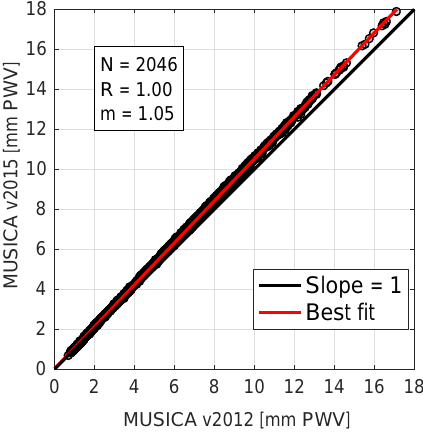
Figure 14. MUSICA v2015 vs. MUSICA v2012 water vapour at Eureka (PEARL Ridge